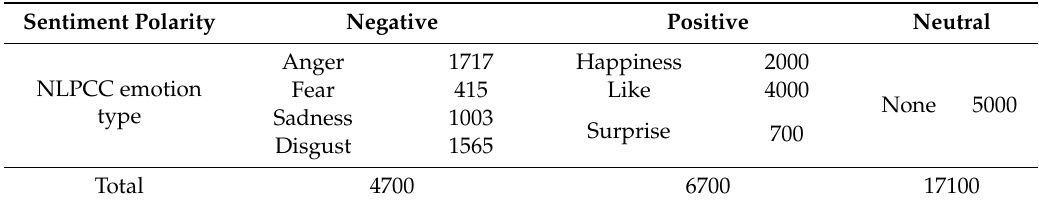
Table 3. The statistics of